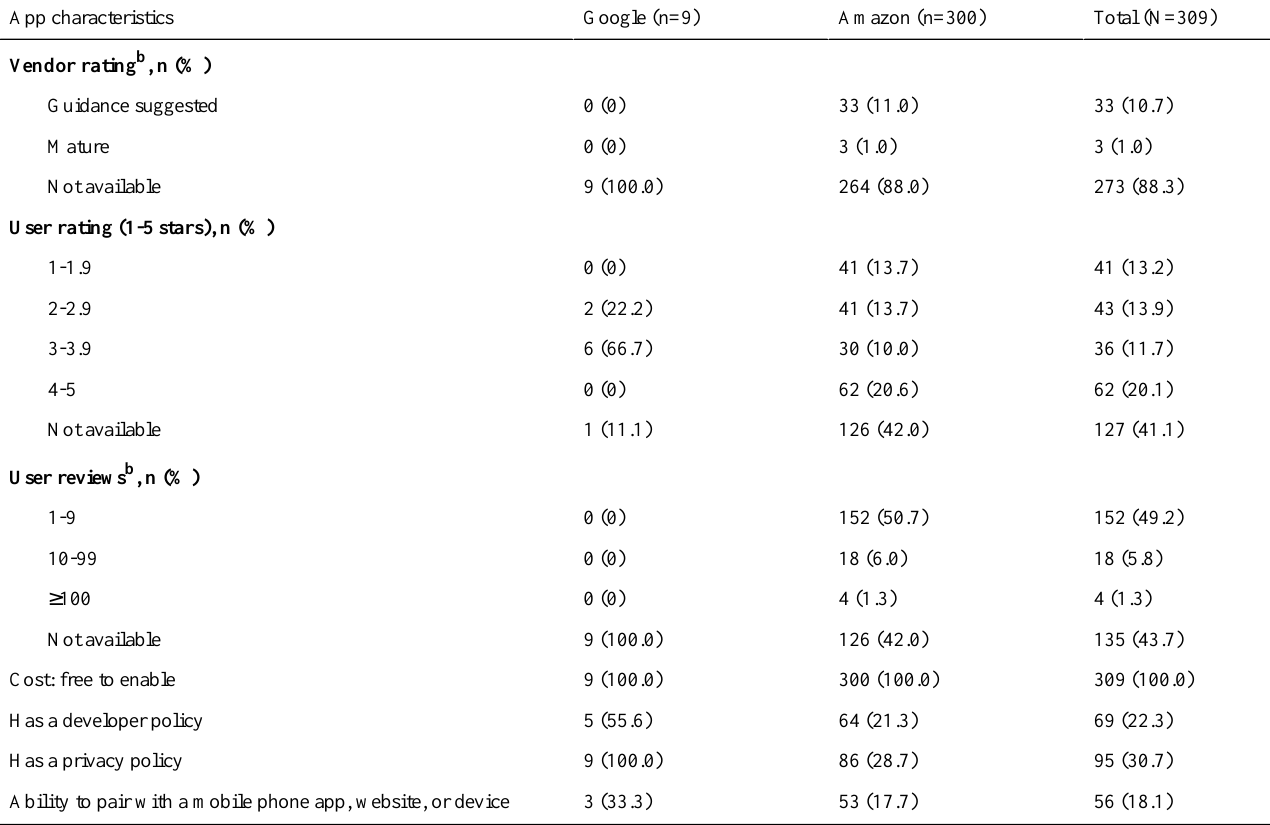
Table 2. Health and fitness app characteristics a